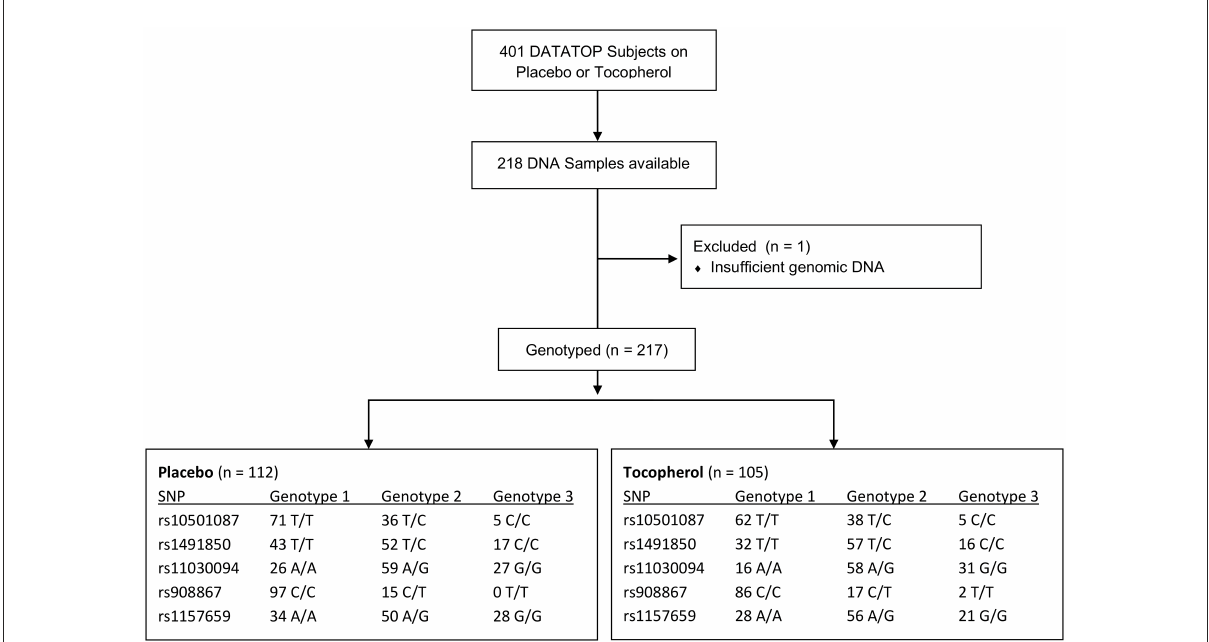
FIGURE1 Flow diagram of sample acquisition and genotype group numbers. Diagrammed are the number of subjects in the DATATOP study, those who consented for DNA samples to be stored and the distribution of genotypes within each treatment arm for each genotype examined.